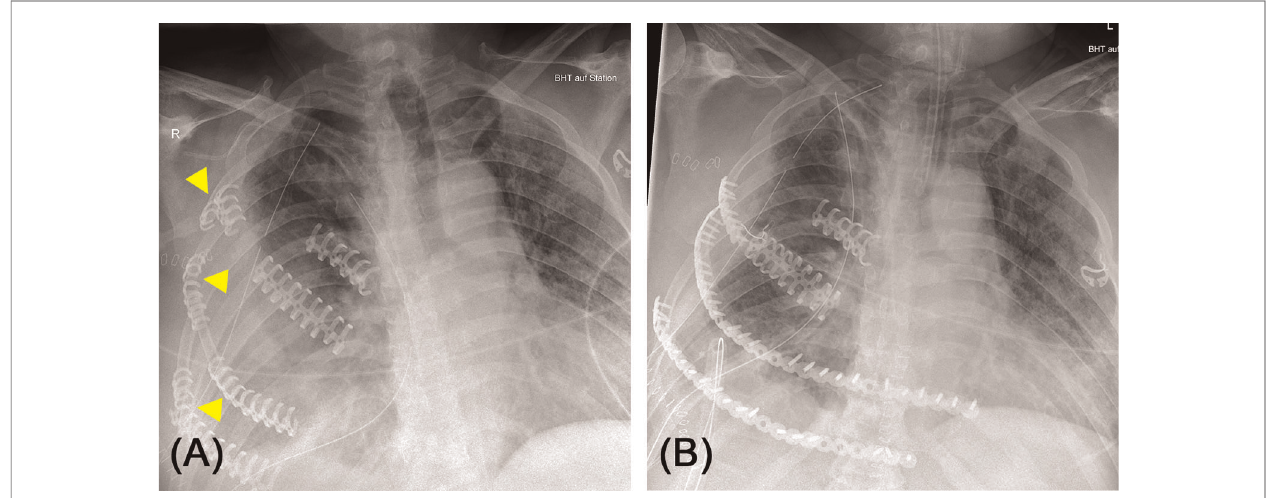
FIGURE 6 | ( A ) 63-year-old male patient after car accident. Surgery for thoracic trauma was carried out at the day of hospital admission including rib fi xation. The patient suffered from severe delirium afterwards. At day 7, chest X-ray revealed several broken osteosynthetic clips (arrows) causing recurrent instability of chest wall. ( B ) Post-operative chest X-ray after re-stabilization of the chest wall replacing broken clips with screwed titanium